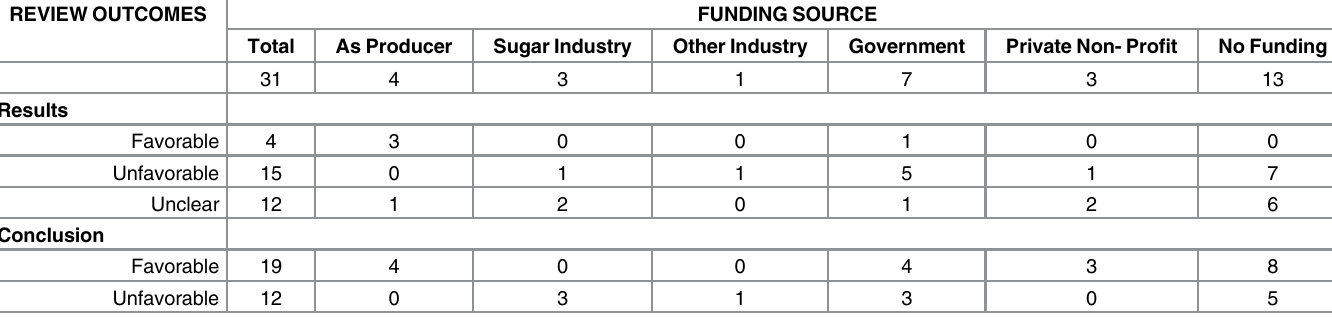
Table 2. Results and conclusions of reviews by funding source (n =